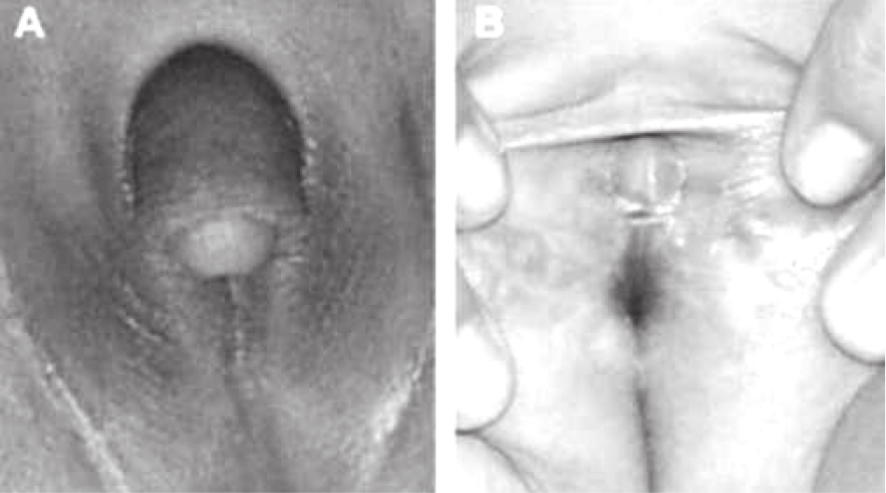
Figure 3 - External genitalia of patient with congenital adrenal hyperplasia before (A) and after (B) genitoplasty - cosmetic result classified as regular